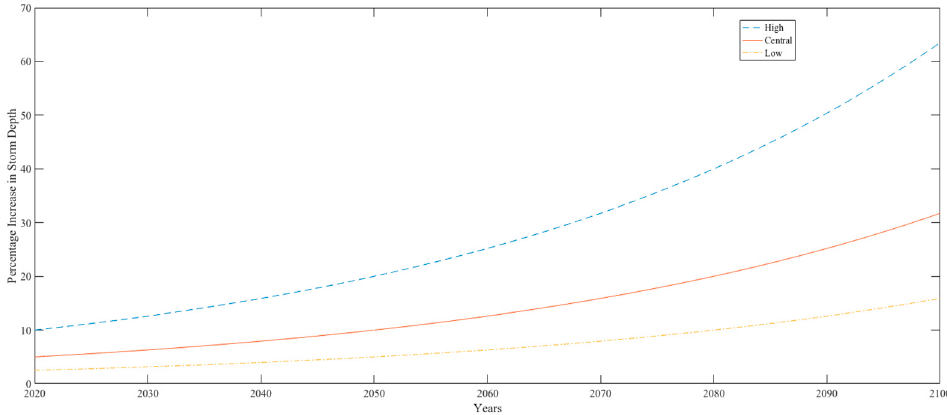
Figure 2. Potential increase in the precipitation depth of rare storm events over time, based upon Environment Agency [13]. The high, medium and low scenarios represent the projections at the ninetieth, fiftieth, and tenth percentiles.